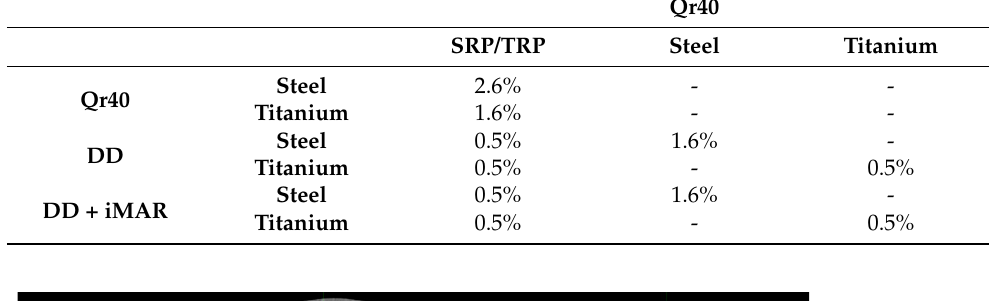
Table 6. The maximum differences in dose, expressed as percentages of the prostate dose (70 Gy), derived from the comparation of the dose distributions on the images acquired at 120 kVp, performed with MIM Maestro ® . Each distribution considered in the comparisons was identified by the image on which it was calculated (i.e., by the type of algorithm used to reconstruct it (Qr40, DD, DD + iMAR) and by the type of metal insert inserted in the phantom (titanium, steel, or none)).